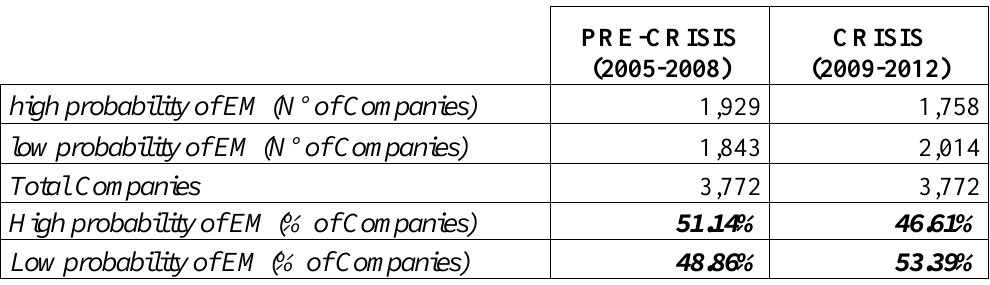
Table 2: Probability of EM Pre-crisis and Crisis Periods